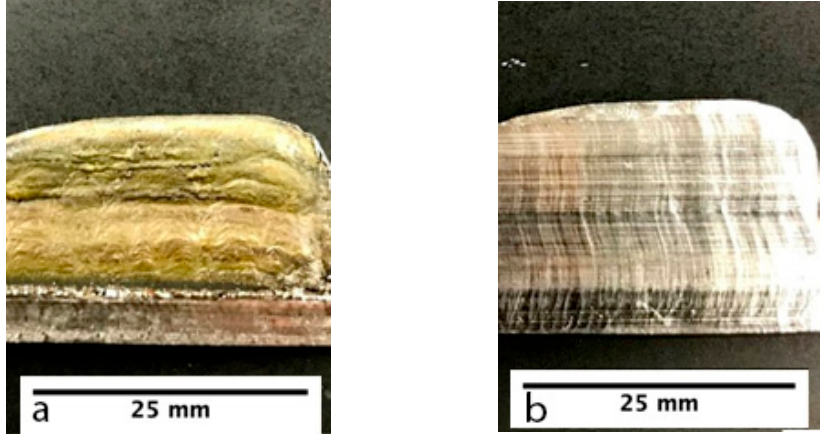
Figure 12. Deposition of a 30-layer wall structure with Inconel 718 alloys produced using parameter set #8 listed in Table 5: ( a ) profile view of the printed wall, ( b ) cross-section view of the printed wall.